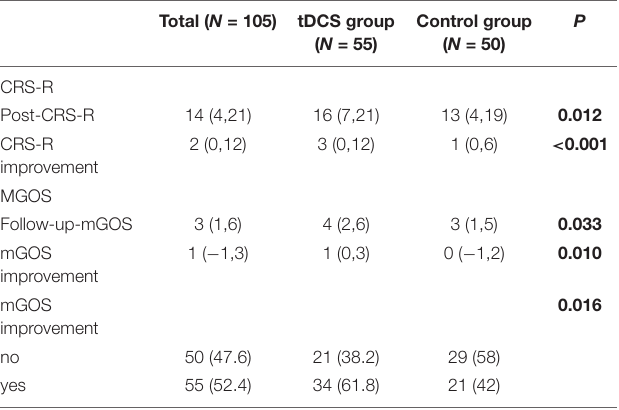
TABLE 3 | Coma Recovery Scale-Revised (CRS-R) and modified Glasgow Outcome Scale (mGOS) score outcomes.